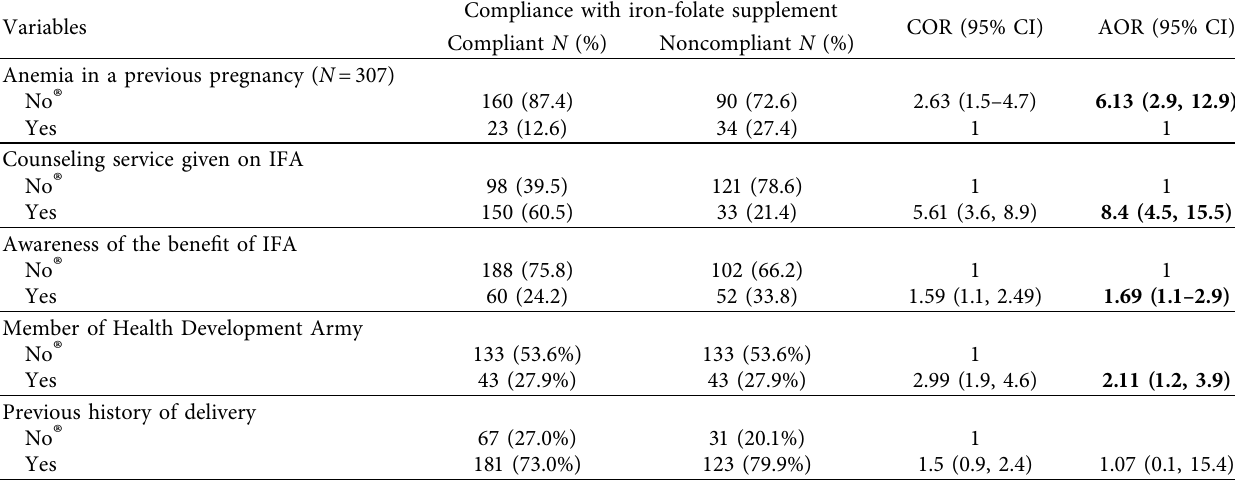
Table 4: Multivariate logistic analysis of factors influencing compliance with iron-folate supplement among pregnant women attending ANC in Shalla district health facilities, West Arsi Zone, Ethiopia, 2019 ( N � 402).